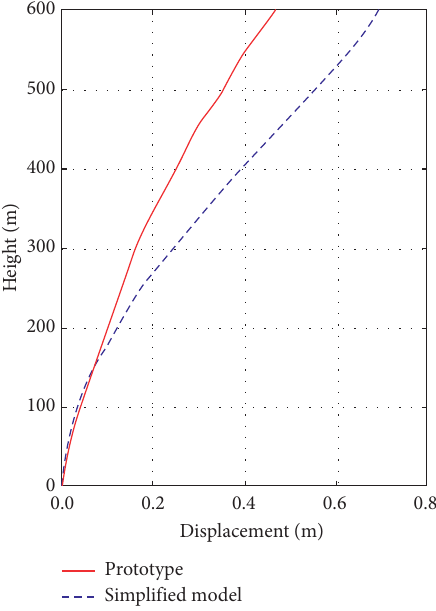
Figure 22: Deformation under a static load. Table 11: The vertex acceleration of the prototype and simplified model (m/s 2